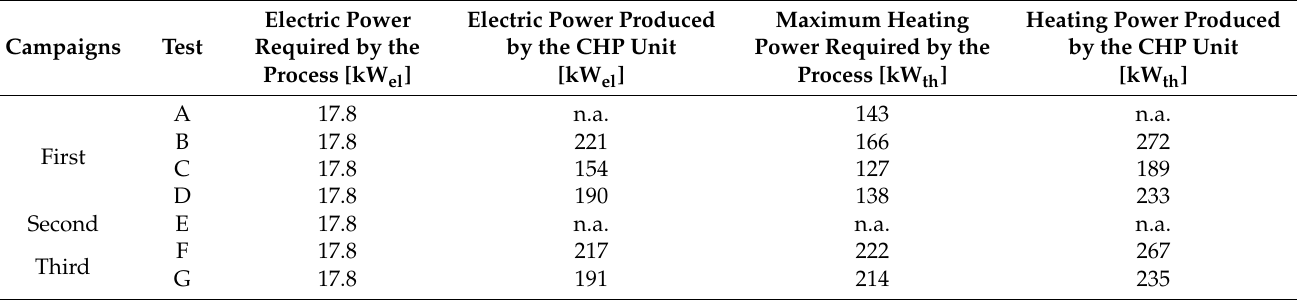
Table 5. Maximum heating requested for the process for each test compared with the heating power produced by the CHP unit (n.a.: not